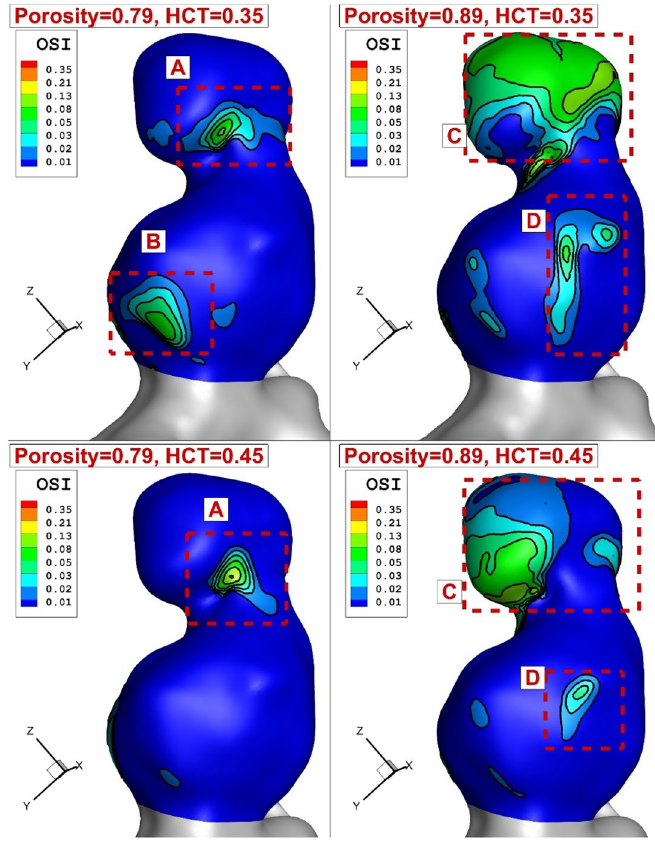
Figure 11. Change of OSI on the aneurysm wall in different HCTs and Coiling porosities.